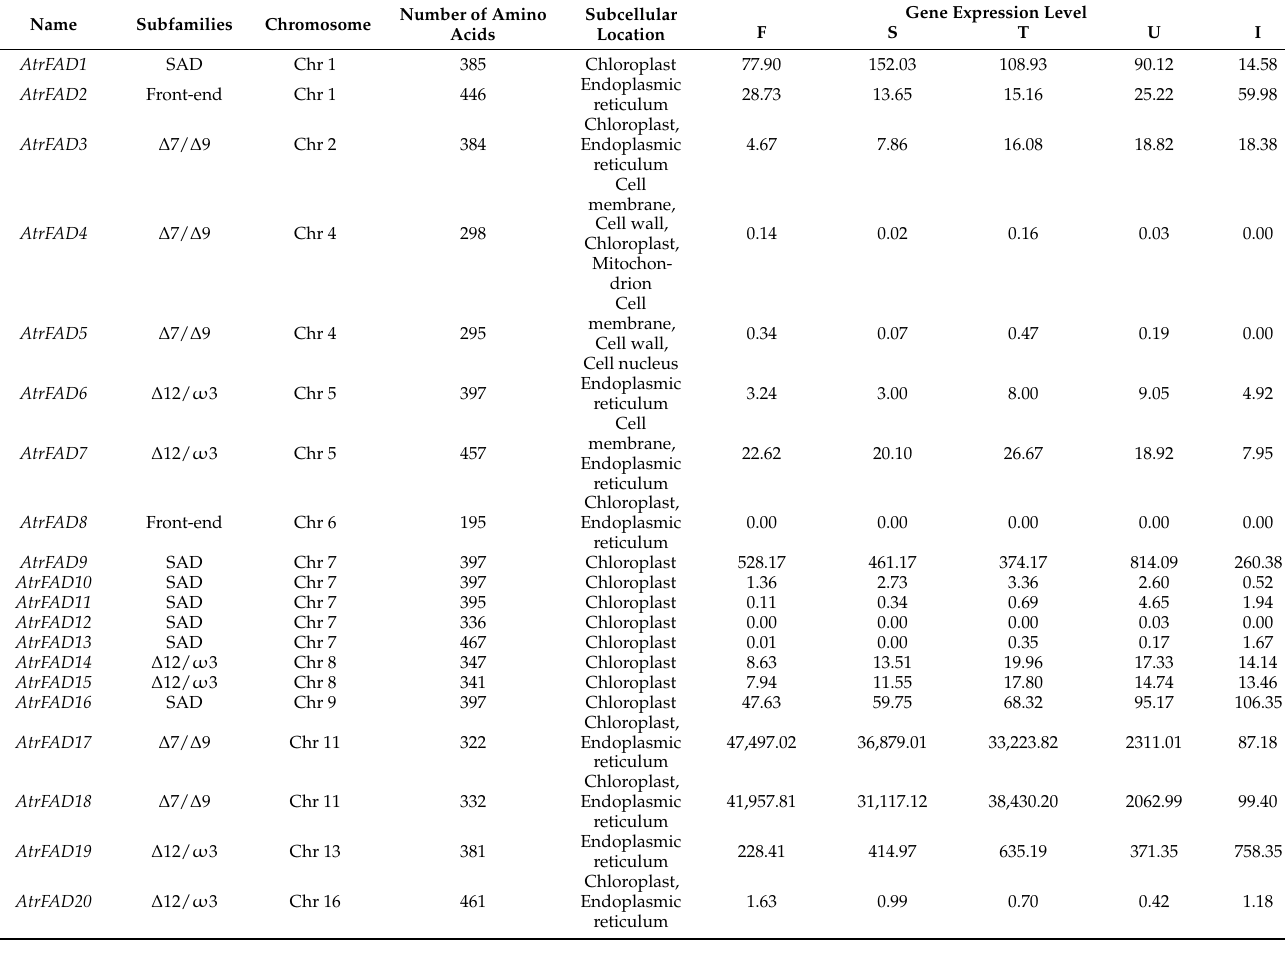
Table 3. Information on AtrFADs.